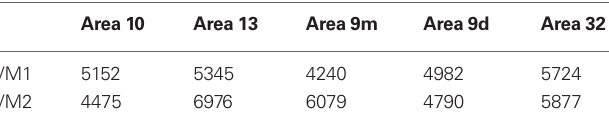
Table 7 | estimates of the total number of spines in the basal dendritic tree of the “average” layer iii pyramidal cell in prefrontal areas of the vervet monkey.